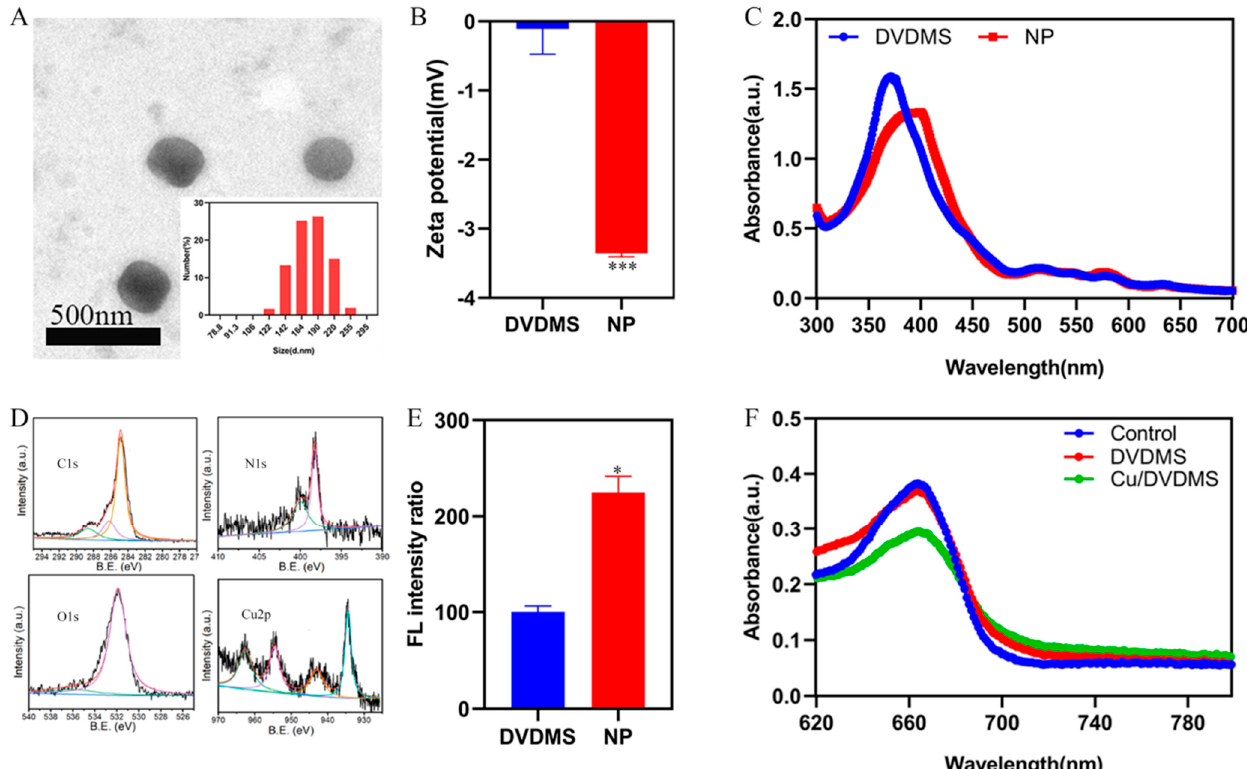
Figure 1. ( A ) DLS and TEM images of Cu/DVDMS. ( B ) Zeta potential of DVDMS and Cu/DVDMS ( n = 3, mean ± SD). ( C ) UV − Vis absorption of DVDMS and Cu/DVDMS. ( D ) XPS wide scans of Cu/DVDMS. ( E ) ROS generation of DVDMS and Cu/DVDMS by DCFH-DA probes under ultrasound treatment (n = 3, mean ± SD). ( F ) Degradation of MB under different conditions in dark, * p < 0.05, *** p < 0.001.